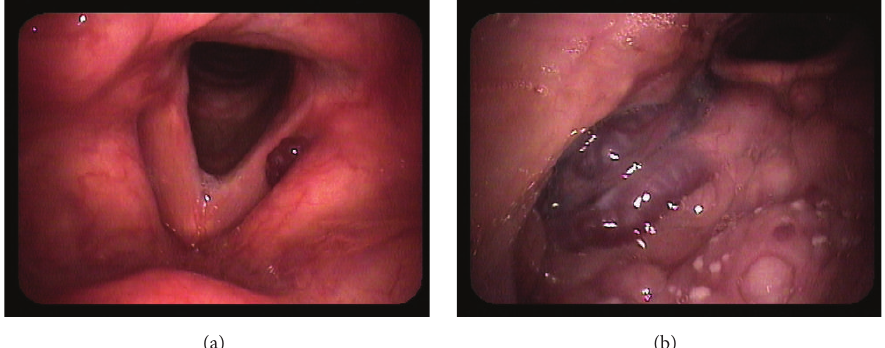
Figure 2: (a) Flexible laryngoscopy showing left laryngeal ventricle lesion. (b) Flexible laryngoscopy showing lesion of the tongue base.